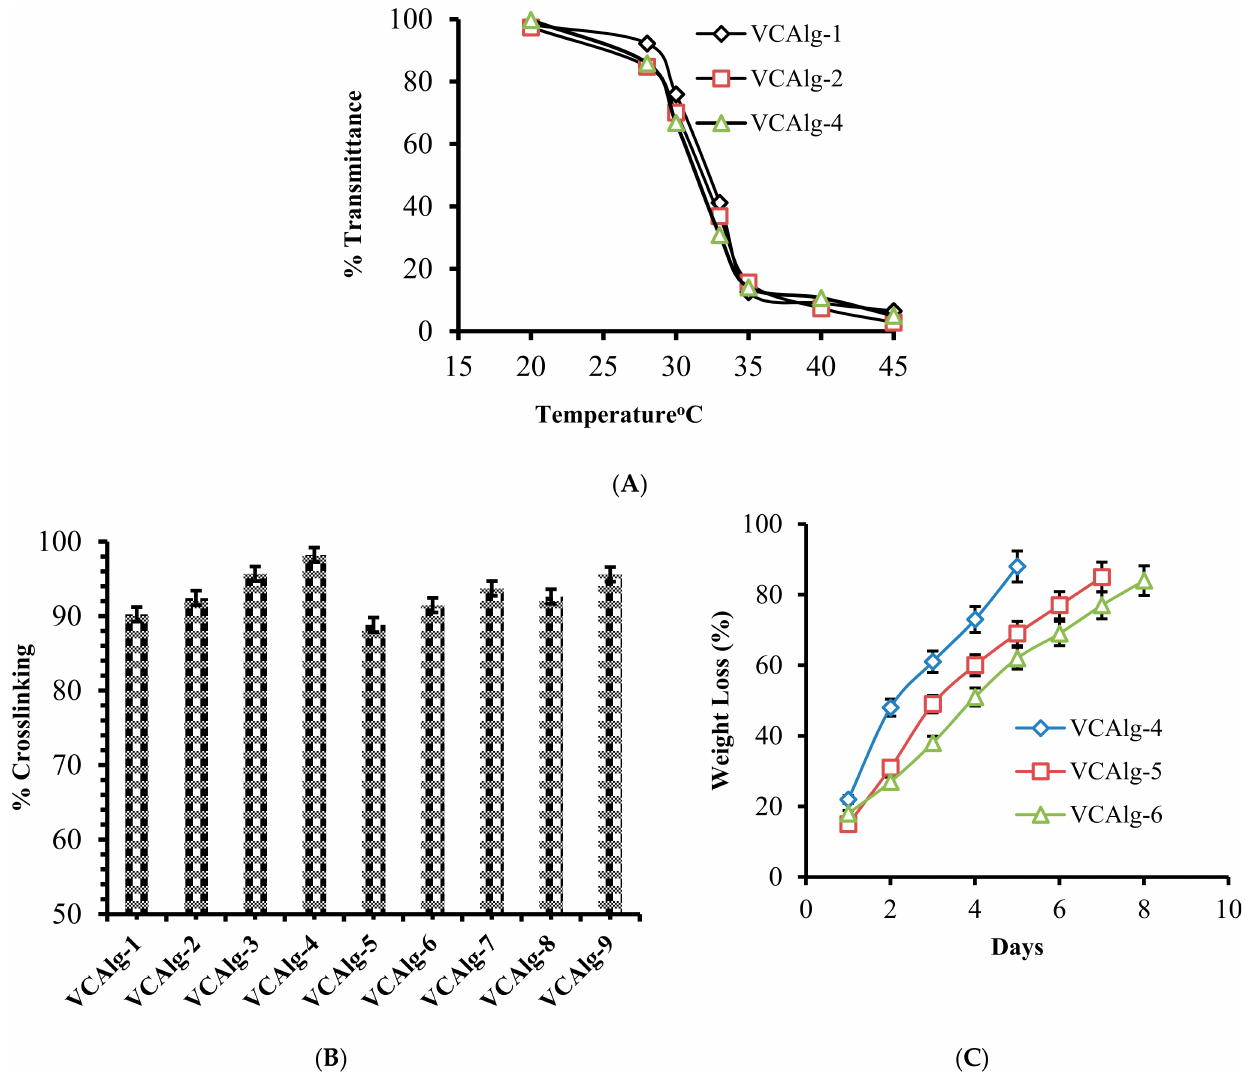
Figure 8. Temperature dependence and effect of increasing polymeric and MBA contents on optical transmittances of thermoresponsive chemically grafted Poly (NVCL-g-NaAlg) depot gels ( A ) Effect of polymeric and crosslinking agent concentrations on percent crosslinking of the chemically grafted Poly (NVCL-g-NaAlg) depot gels ( B ). The data were analyzed for statistical significance with one-way ANOVA. The data were found statistically significant with p -value of <0.01. In vitro degradation profile of chemically grafted Poly (NVCL-g-NaAlg) depot gels at 37 ◦ C ( C ). All the experiments were conducted in triplicates (n =